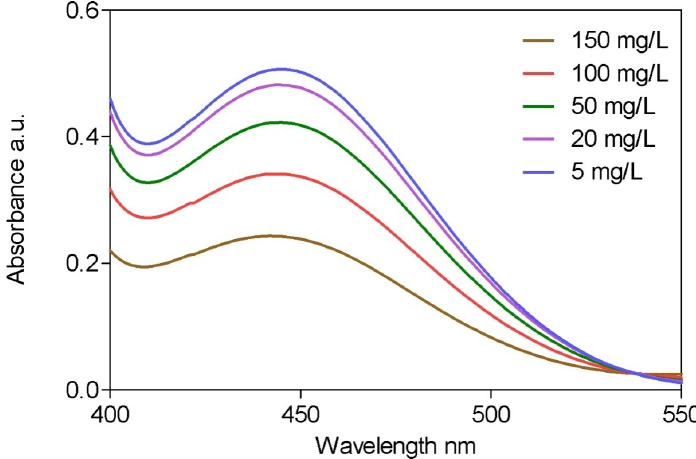
Figure 2. UV-vis absorption spectra measured from 400 to 550 nm for ethyl alcohol concentrations in mixture ranged from 5 to 150